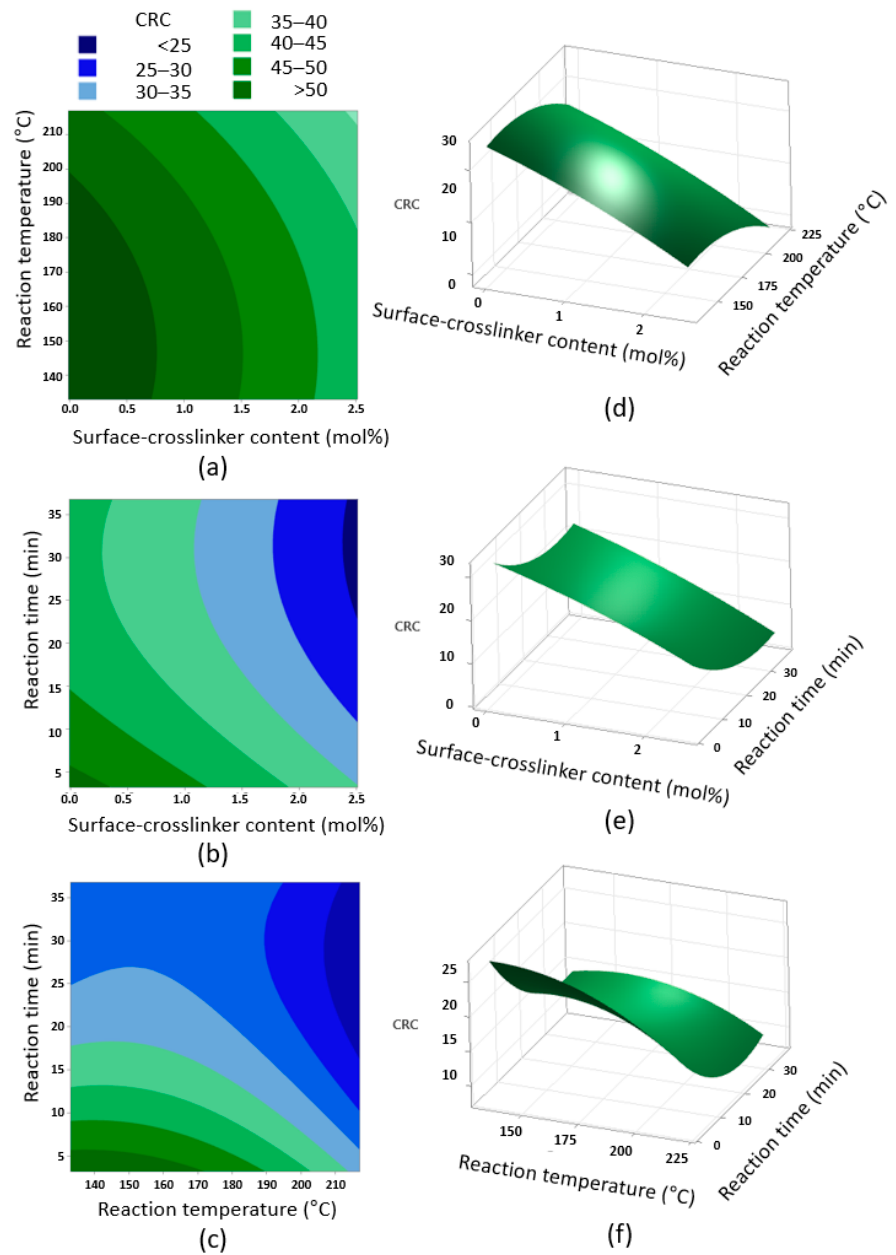
Figure 4. Contour and 3D surface plots via CCD of RSM between each parameter of CRC: ( a ) contour plot of CRC versus surface-crosslinker content and reaction temperature, ( b ) contour plot of CRC versus surface-crosslinker content and reaction time, ( c ) contour plot of CRC versus reaction temperature and reaction time, ( d ) 3D surface plot of CRC versus surface-crosslinker content and reaction temperature, ( e ) 3D surface plot of CRC versus surface-crosslinker content and reaction time, and ( f ) 3D surface plot of CRC versus reaction temperature and reaction time.